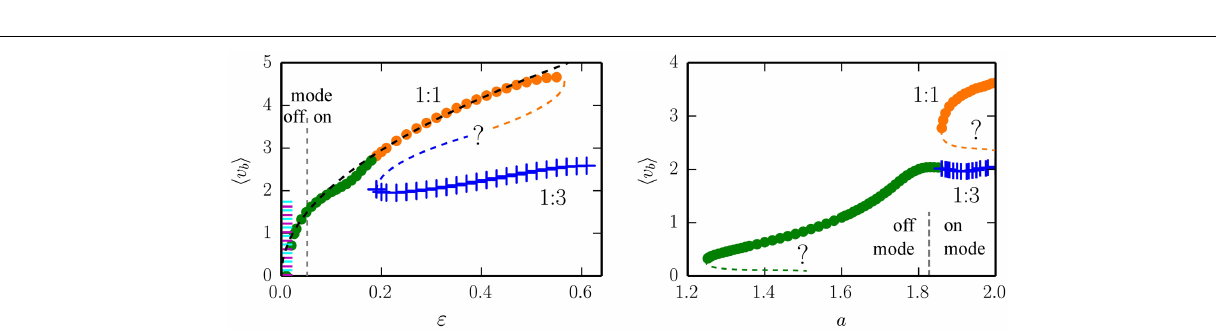
FIGURE 5 | The average speed < v b > of the one-rod barrel for the 1:1 (green/orange dots) and for 1:3 (blue crosses) mode . The vertical dashed line denotes the locus of the Hopf bifurcation line shown in Figure 3 . In the off mode (on mode), the attracting state for the non-rolling mode is a stable fixpoint (limit cycle), respectively. Presumably existing unstable limit cycles are indicated by dashed lines (labeled with question marks). Left: for a gain a = 1.9. The colored region for very small adaption rates ε indicates a region with both stable and drifting back-and-forth modes, further described in Figure 6 . Right: for an adaption rate ε = 0.25.